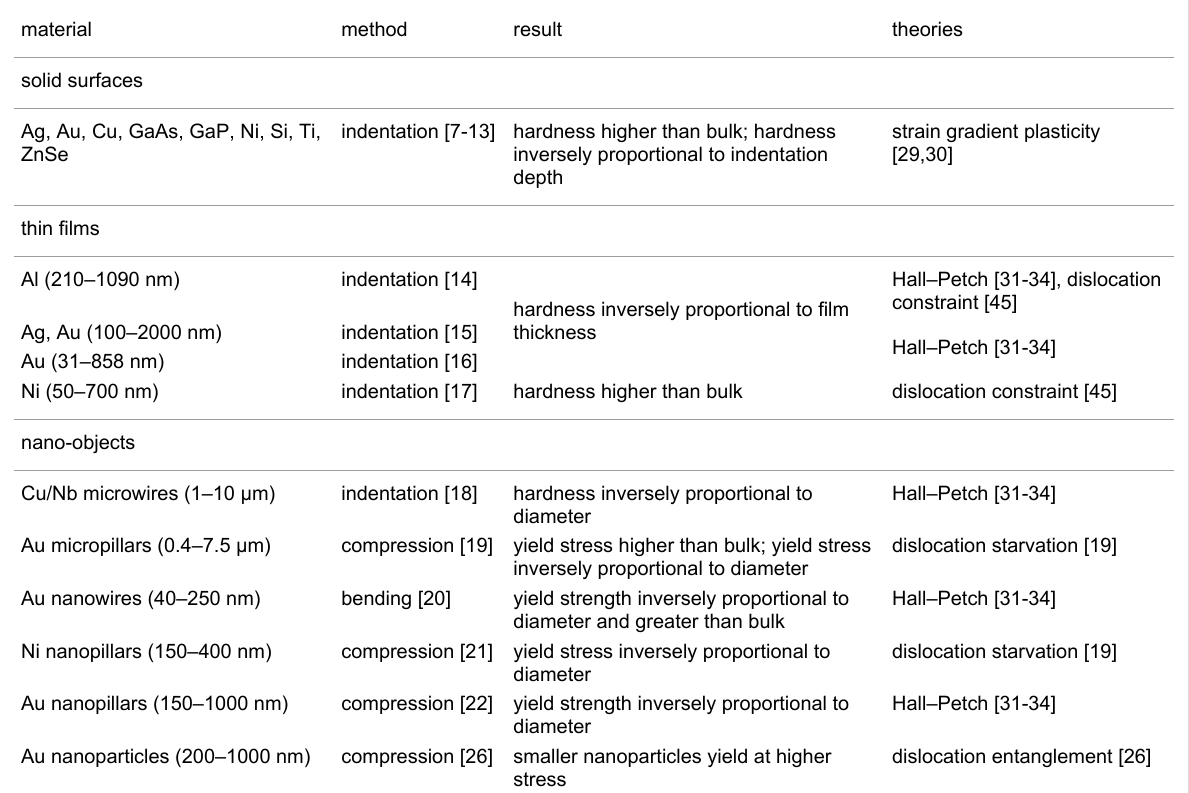
Table 1: Review of studies of enhanced scale-dependent mechanical properties of bulk solid surfaces, thin films and various nano-objects. For thin films, the thicknesses are given and for nano-objects, the diameters are given. Pillars described in the studies have low aspect ratios (2–20) compared to wires